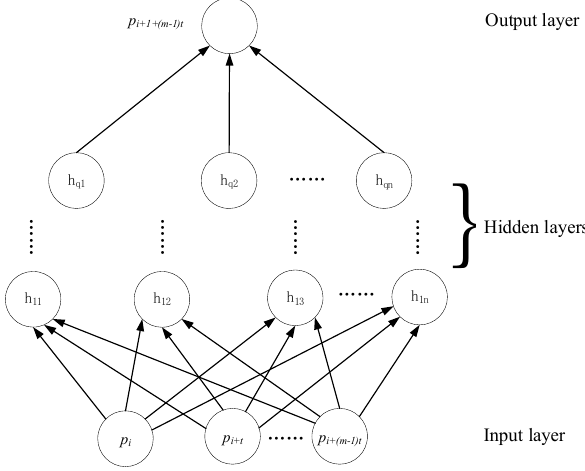
Figure 3. Deep neural network structure.